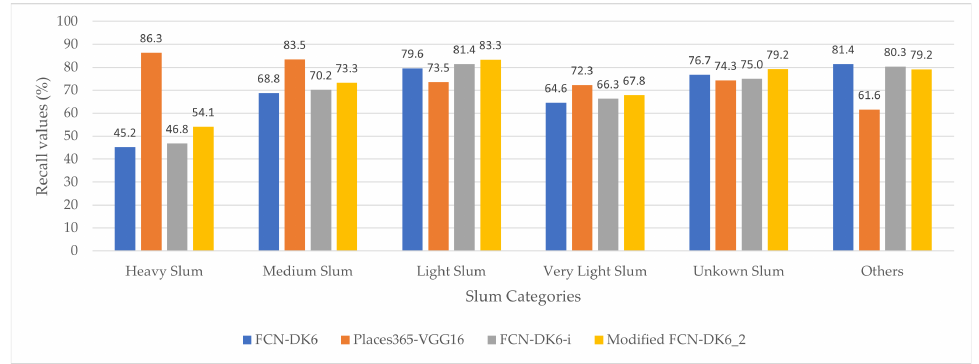
Figure 11. The outcome generated by FCN-DK6, Places365-VGG16, FCN-DK6-i and Modified FCN- DK6_2 networks is compared across the various slum